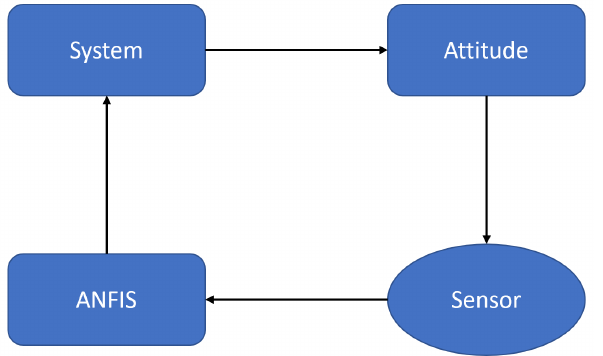
Figure 7. Block diagram of the control system using the ANFIS integrated controller and observer of the marine rescue drone.